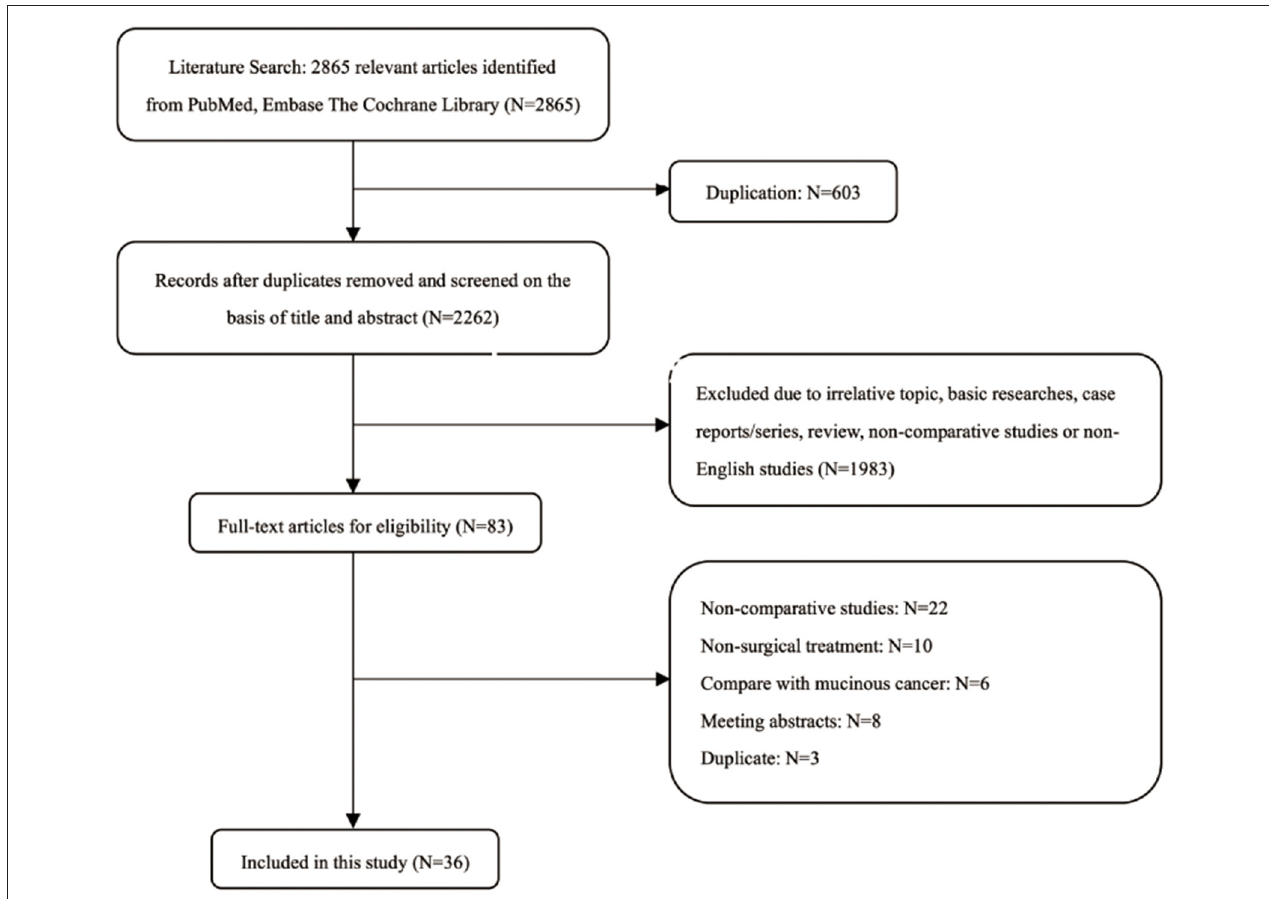
FIGURE 1 | Flow chart of literature